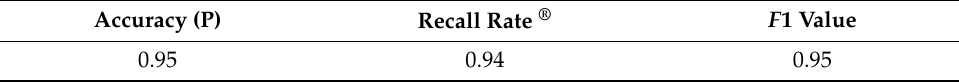
Table 6. Evaluation index.